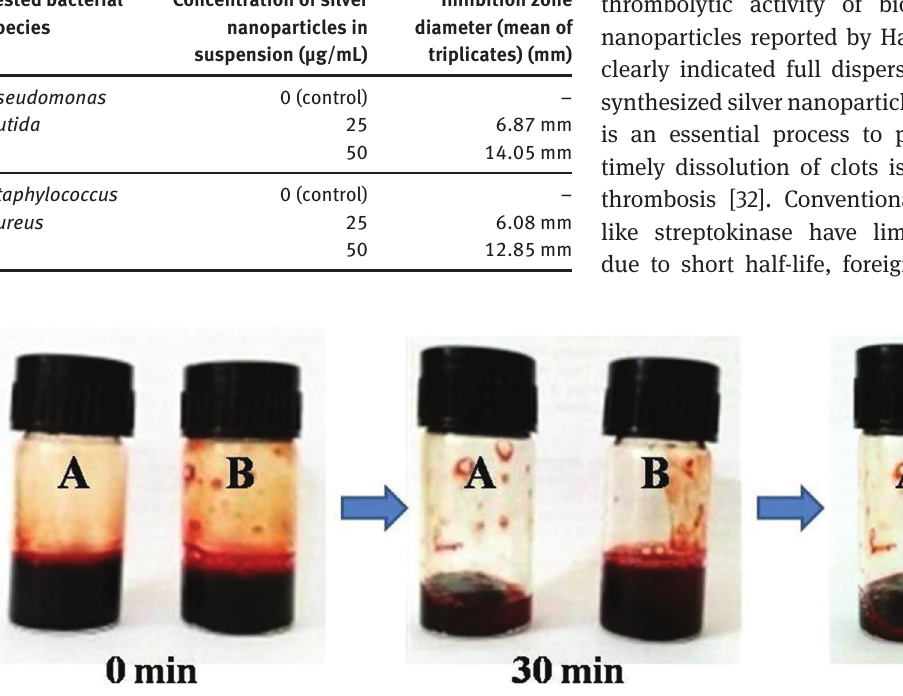
Figure 9: Anticoagulant activity of silver nanoparticles.